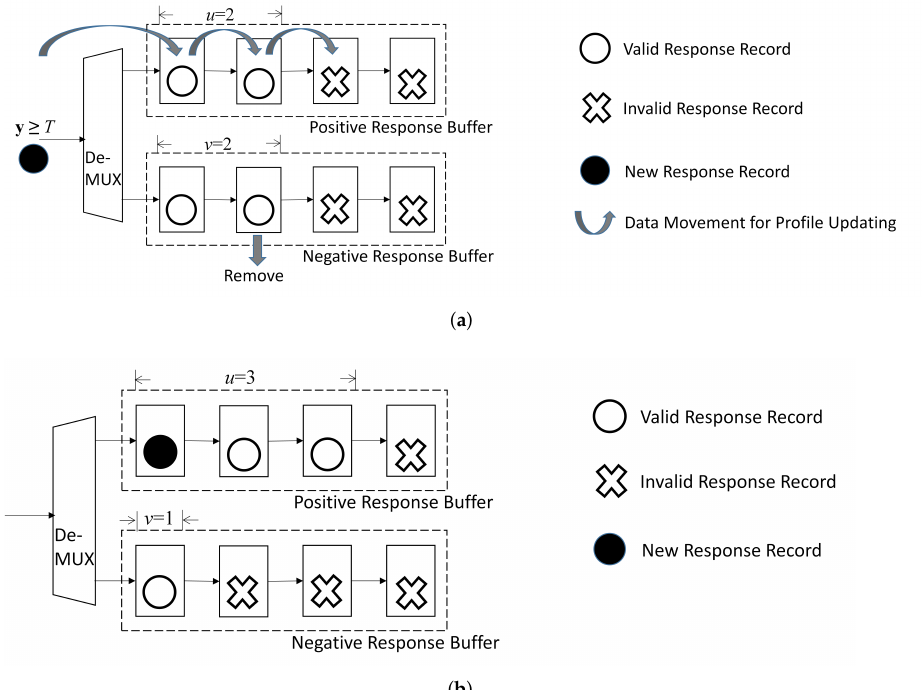
Figure 10. A simple example for updating buffers in profile updating unit for p = C . In this example, p = 4, C = 4, u = 2 and v = 2 before updating. Assume y ≥ T for the new record. The new record is then assigned to positive response buffer. After updating, p = 4, u = 3, and v = 1. ( a ) Before updating; ( b ) After